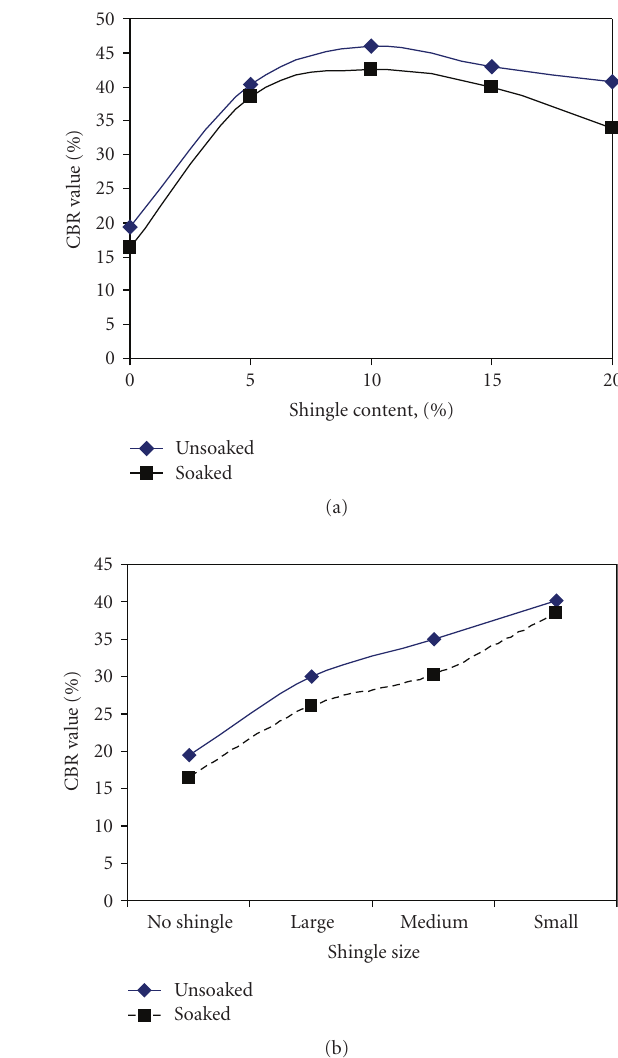
ff erent shingle contents (small-size shingles and no CKD) and (b) di ff erent shingle sizes (5% shingle and no